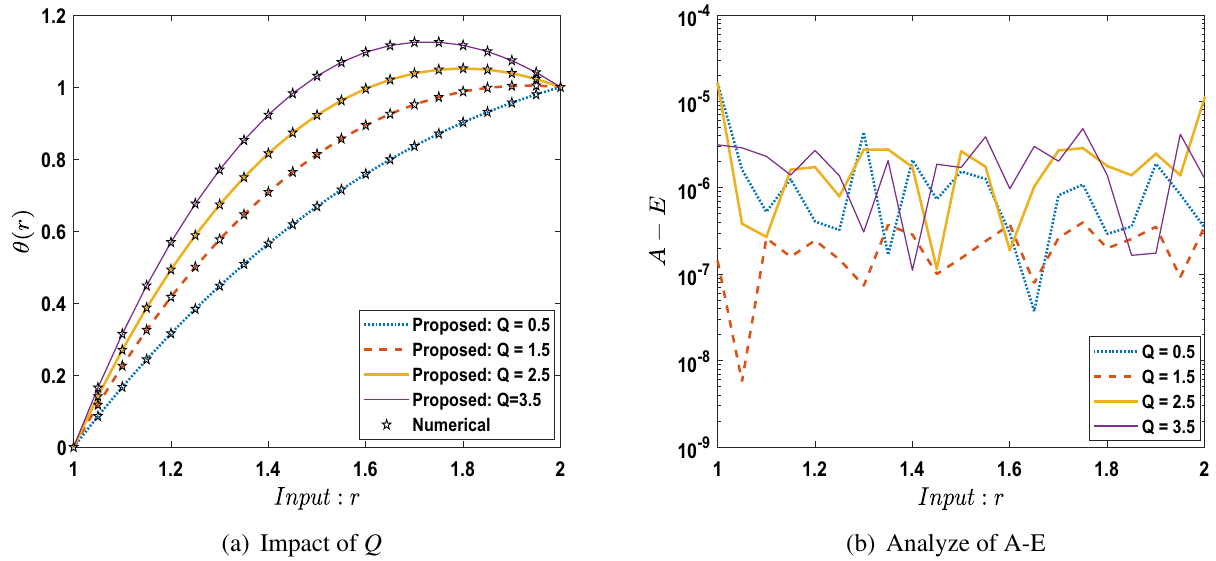
Figure 22. Comparison between LMA-TNN with results of numerical reference for scenario 2 in constant viscosity.